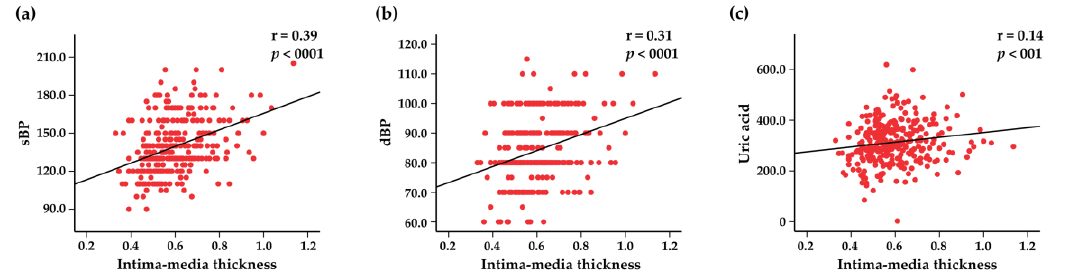
Figure 5. Scatter plots representing the correlations between intima–media thickness and systolic blood pressure (sBP) ( a ), diastolic blood pressure (dBP) ( b ), and blood uric acid levels ( c ).